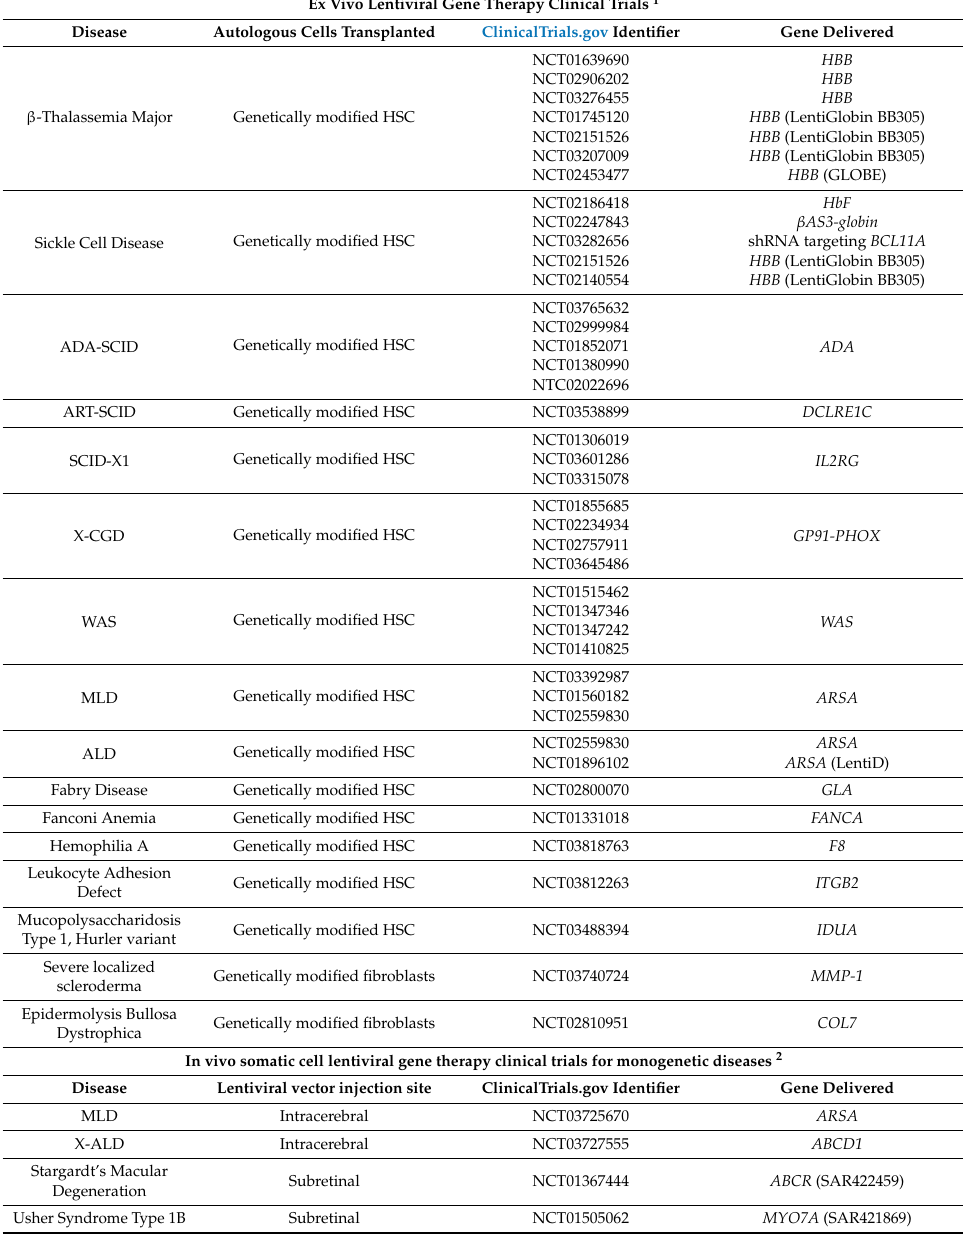
Table 1. Current and completed gene therapy clinical trials using lentiviral vectors for monogenetic